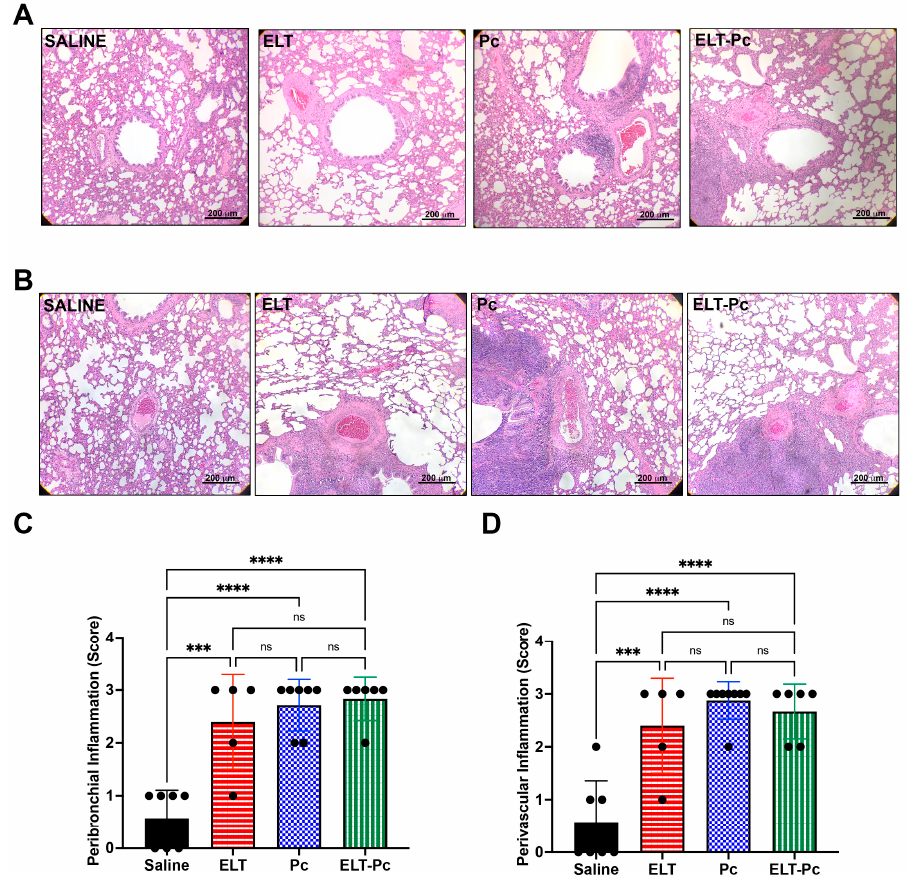
Figure 2. Evaluation of peribronchiolar and perivascular inflammation cuffs in the elastase-induced COPD model infected with Pneumocystis . Lung sections of rats from the four experimental groups were stained with hematoxylin-eosin and the presence of inflammation cuffs were identified by microscopic evaluation in images with 100 × magnification. ( A ) Peribronchiolar and ( B ) perivascular inflammation cuffs were identified in the images. Quantification of the cuffs observed in the images was determined using a score described in the Materials and Methods section. Quantification of ( C ) peribronchiolar and ( D ) perivascular inflammatory cuffs is indicated. Data are expressed as mean ± SD and analyzed by ANOVA. ns = nonsignificant; *** = p < 0.001; **** = p < 0.0001.